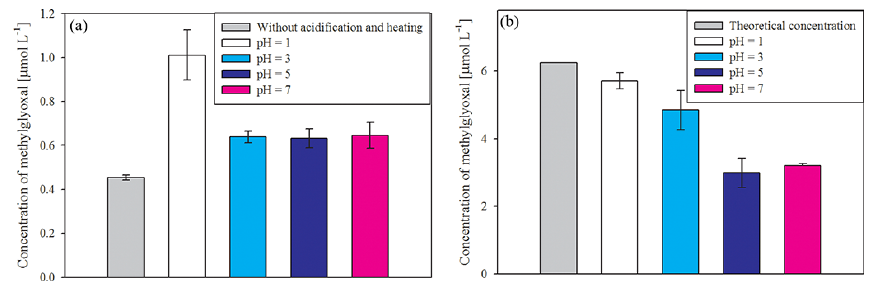
Figure 2. Influence of pH on the detected methylglyoxal concentration in filter samples (a) and the methylglyoxal standard solution (b) .